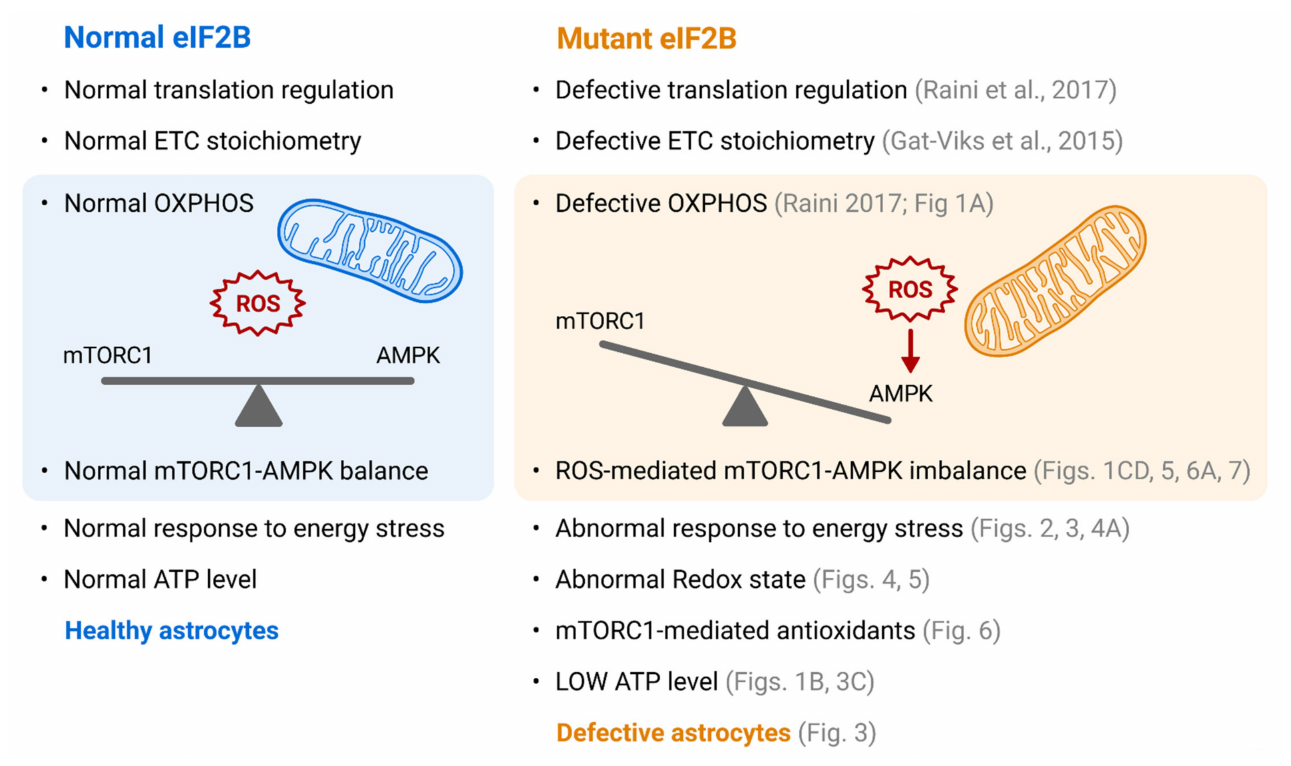
Figure 8. Blue panel, WT healthy astrocytes. eIF2B, a master regulator of mRNA translation, is responsible for the correct stoichiometry of electron transfer chain (ETC) complexes, thus allowing effective oxidative phosphorylation (OXPHOS). The cells are able to produce sufficient ATP amounts, as needed. They exhibit normal level of reactive oxygen species (ROS), normal AMPK and mTORC1 activities and are able to normally respond to energy stress. Therefore, astrocytes expressing WT eIF2B are healthy and fully functional. Orange panel, astrocytes expressing hypo-active eIF2B due to VWMD mutation in Eif2b5 gene. The cells exhibit defective translation regulation and defective stoichiometry of ETC complexes, resulting in OXPHOS deficit. They suffer from low ability to produce sufficient ATP amounts and compromised ability to adapt to energy stress. They demonstrate ROS-dependent impaired AMPK-TORC1 balance since they require high mTORC1-mediated translation to allow oxidative glycolysis and high level of antioxidants (similarly to cancer cells) which keep their steady-state ROS below normal level. Eif2B5-mutant astrocytes are functionally